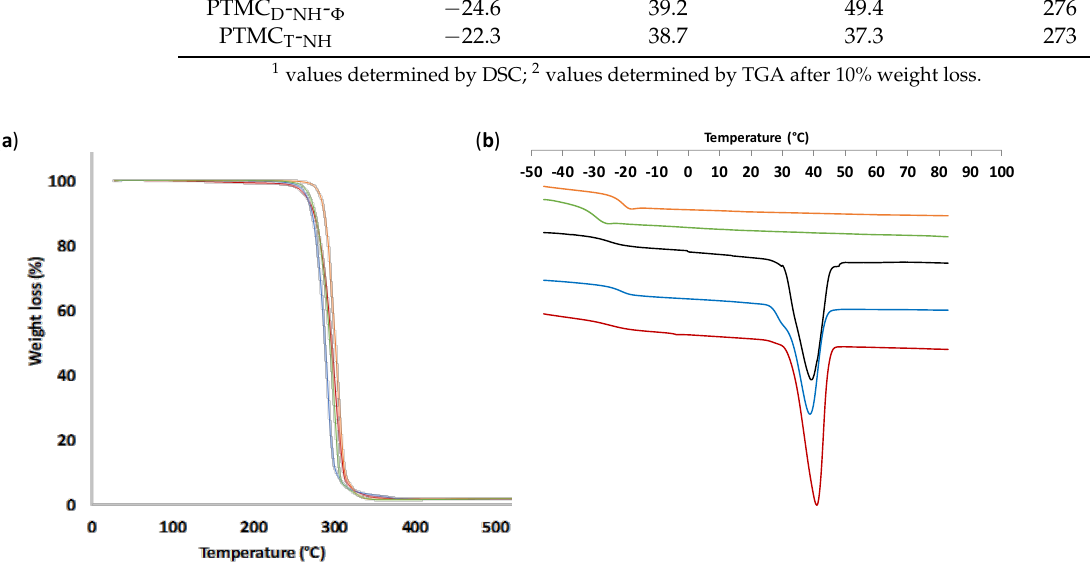
Figure 6. Thermal properties of PTMC D - OH (orange); PTMC M - NH (green); PTMC T - NH (blue); PTMC D - NH (red); PTMC D - NH - Φ (black). ( a ) Thermal gravimetric analysis; ( b ) differential scanning calorimetry traces.